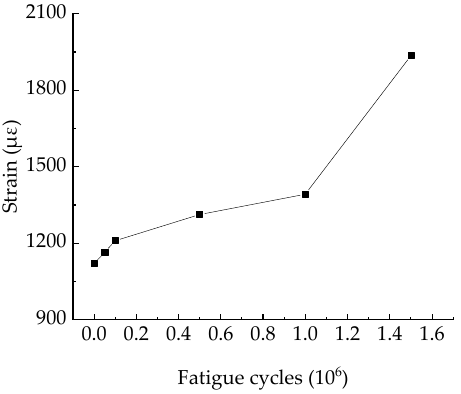
Figure 18. The relationship between the reinforcement strain and fatigue cycles of P2.